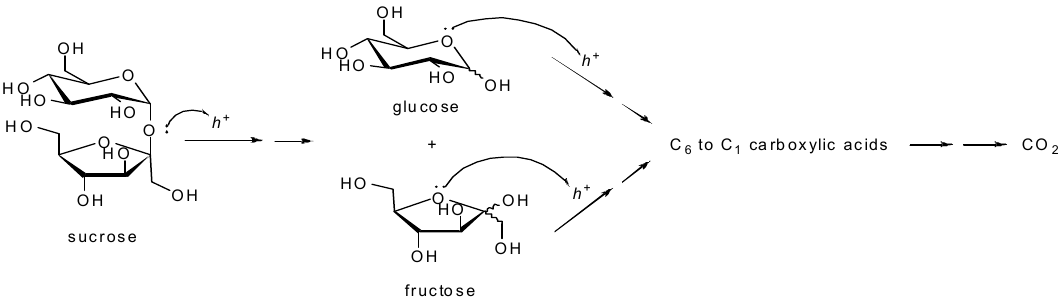
Scheme 4. Photocatalytic mineralization pathway of sucrose, glucose, and fructose proposed